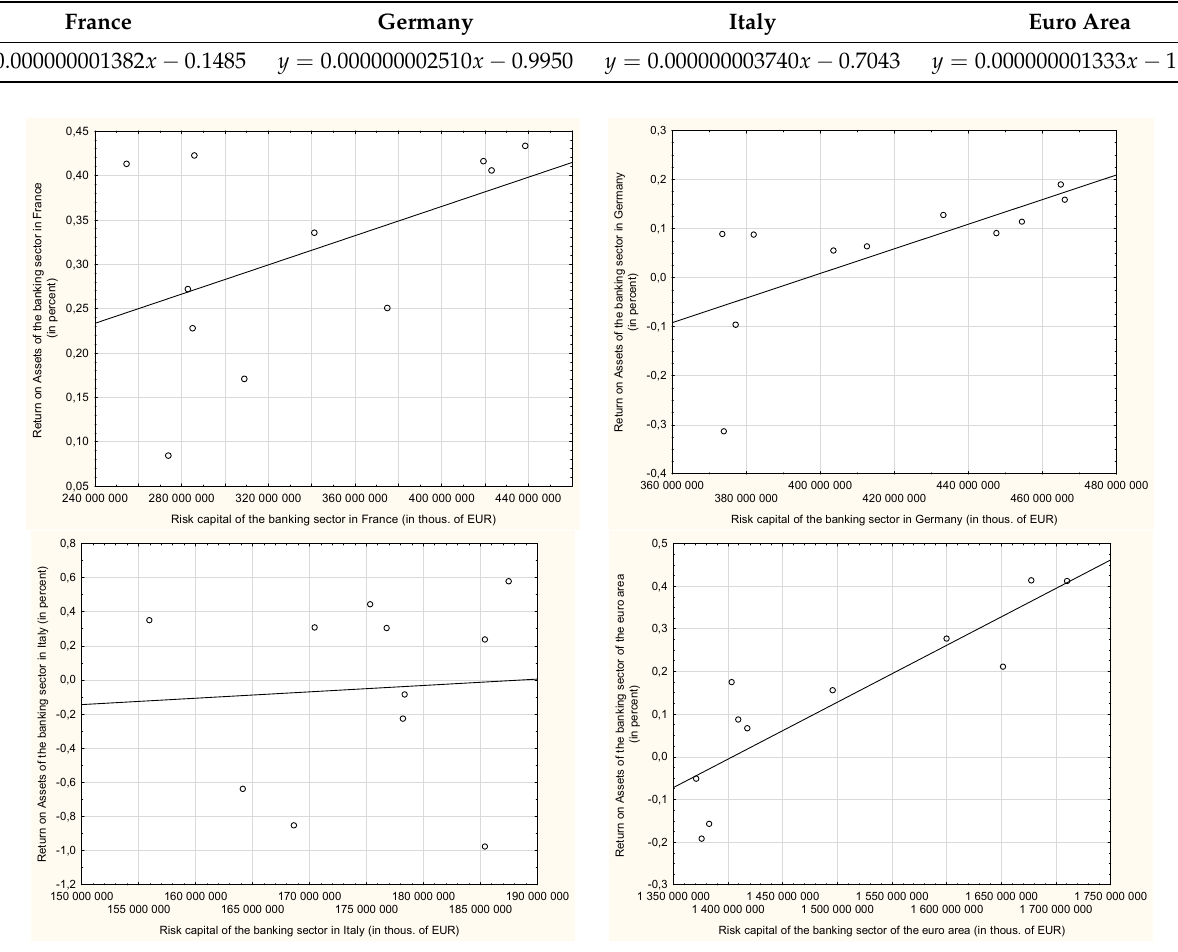
Figure 4. Two-dimensional scatterplots of stage 1 (source: own work).